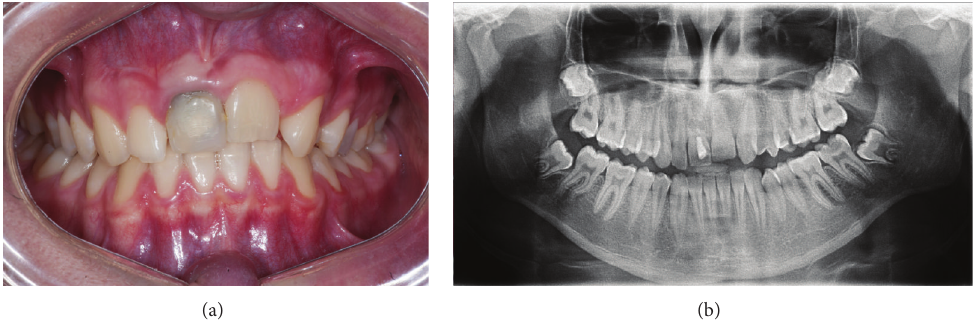
Figure 8: Six-year follow-up findings. (a) Intraoral photograph showing the discoloration of the maxillary right central incisor, infraocclusion of both central incisors, and midline shift. (b) Panoramic radiograph showing internal resorption in the maxillary right central incisor and ankylosis of the left central